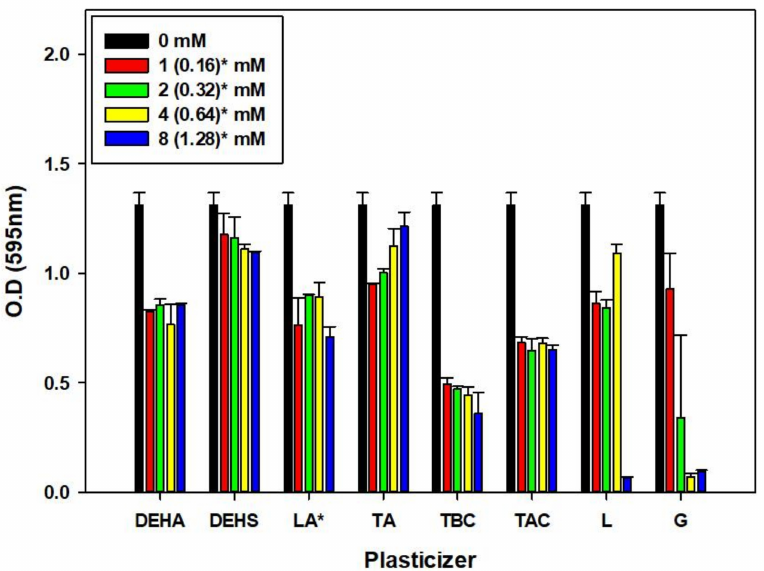
Figure 1. Growth tendency with the addition of various plasticizers. The cell growth pattern of Microbulbifer sp. SOL66 was expressed as optical density with the addition of plasticizers at concentrations of 1 mM, 2 mM, 4 mM, and 8 mM, lauric acid* was added at 0.16 mM, 0.32 mM, 0.64 mM, and 1.28 mM due to solubility